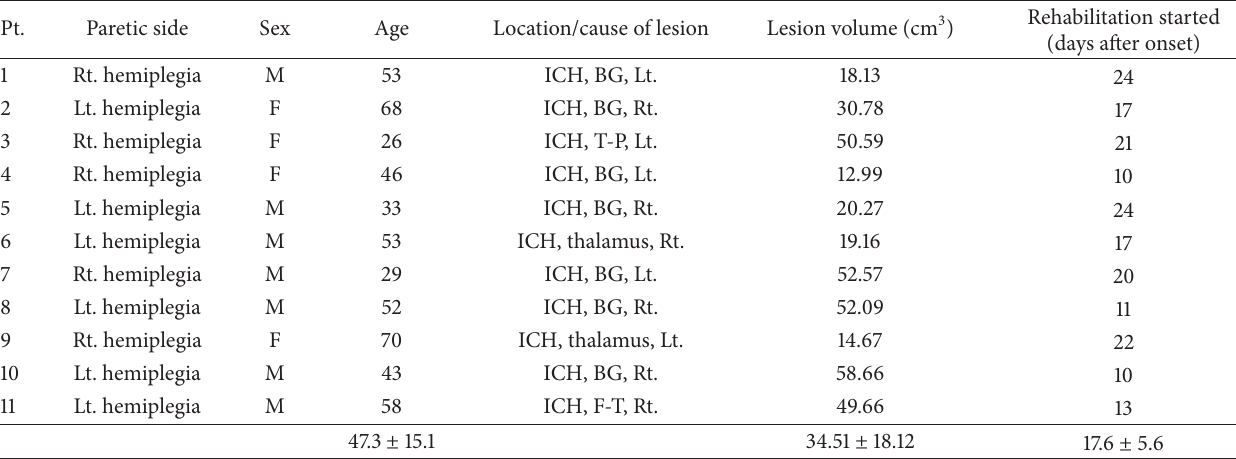
Figure 2: Overlay of lesions in the patients with hemorrhagic stroke. The top two figures represent the subject’s upper limb motor function. The bottom shows the subtraction analysis in which the overlay of patients with isolated movement recovery was subtracted from the overlay of those with mass synergic movement recovery. (a) Overlay of lesions for patients with a synergic upper limb ( 𝑛 = 6 ). (b) Overlay of lesions for patients with an isolated upper limb ( 𝑛 = 5 ). (c) Subtraction analysis using (a) and (b). Table 1: Baseline characteristics and lesion size of